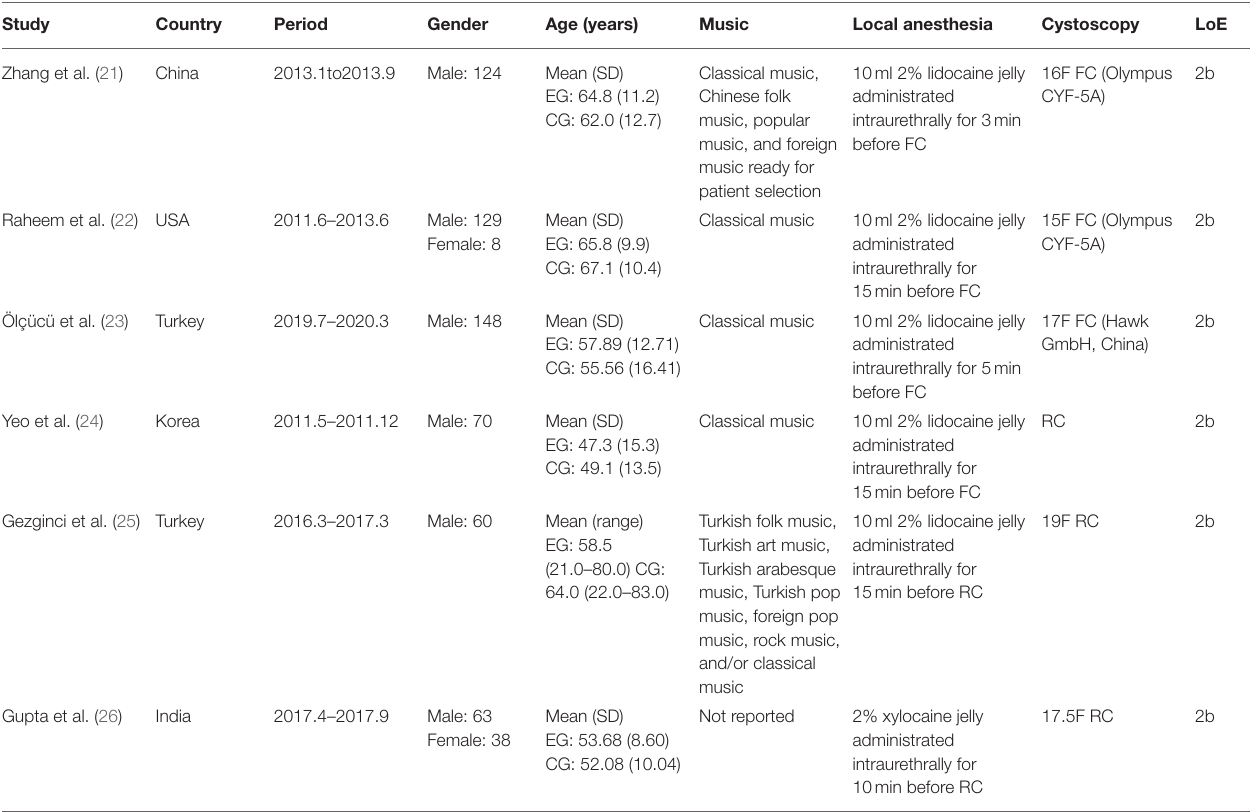
TABLE 1 | The main characteristics of included studies in this meta-analysis.